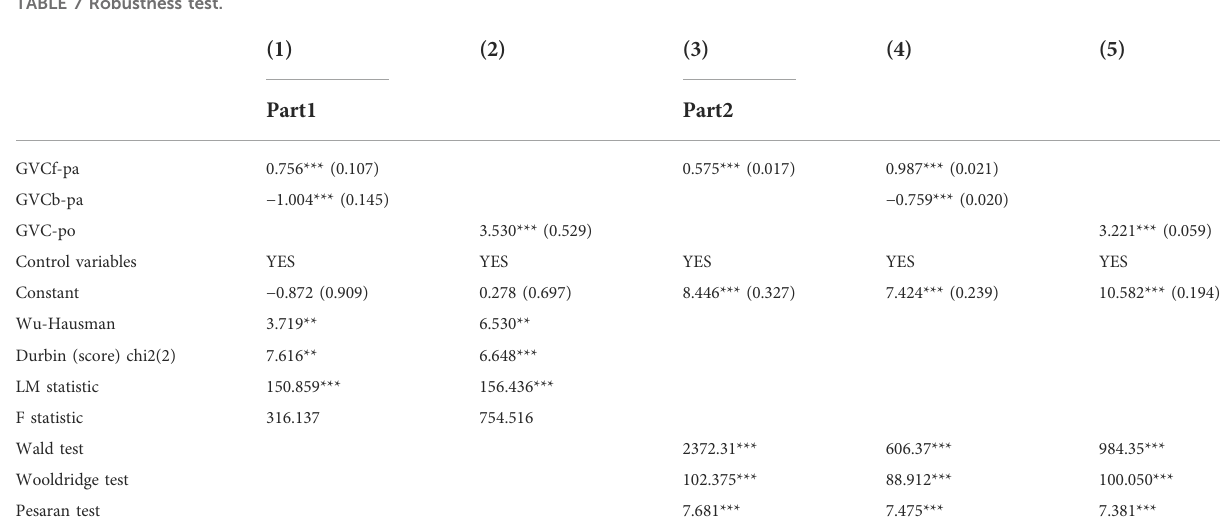
TABLE 7 Robustness test.